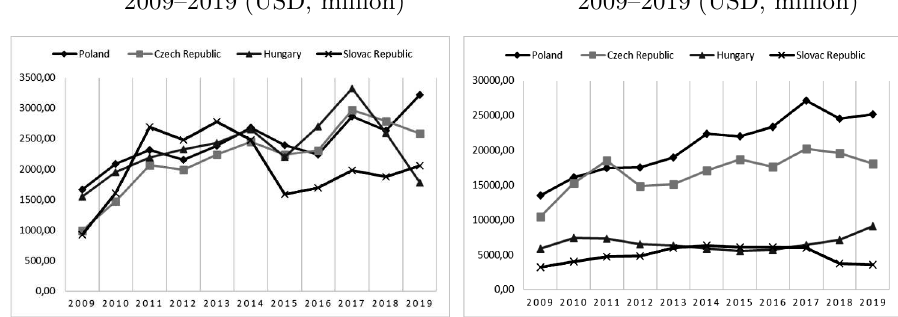
Figure 5. Export to China of V4, Figure 6. Import from China of